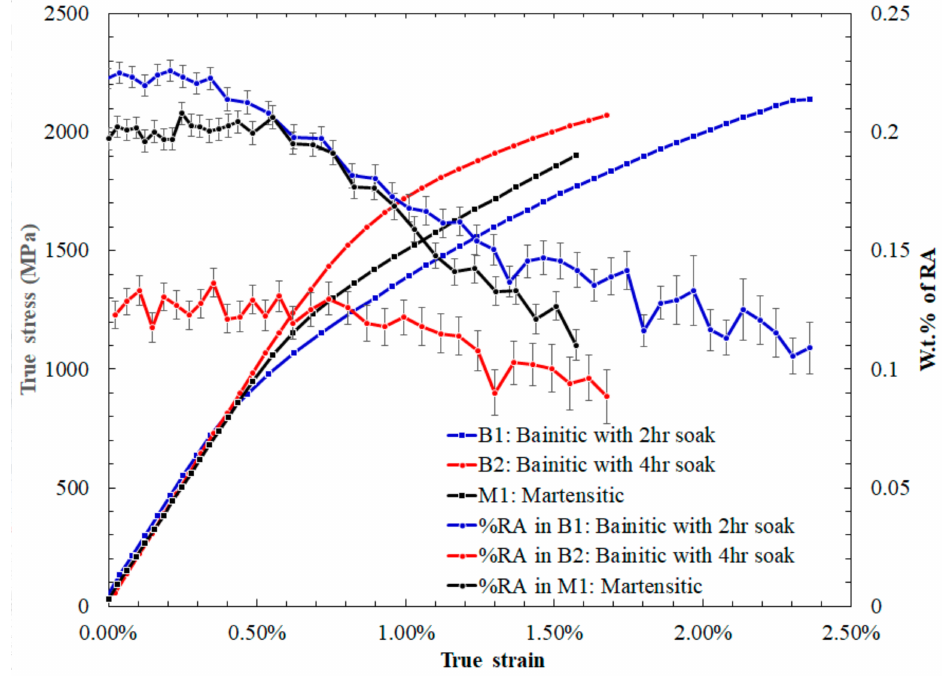
Figure 4. Macroscopic stress vs true strain with respect to retained austenite (RA) transformation for B1, B2, and M1